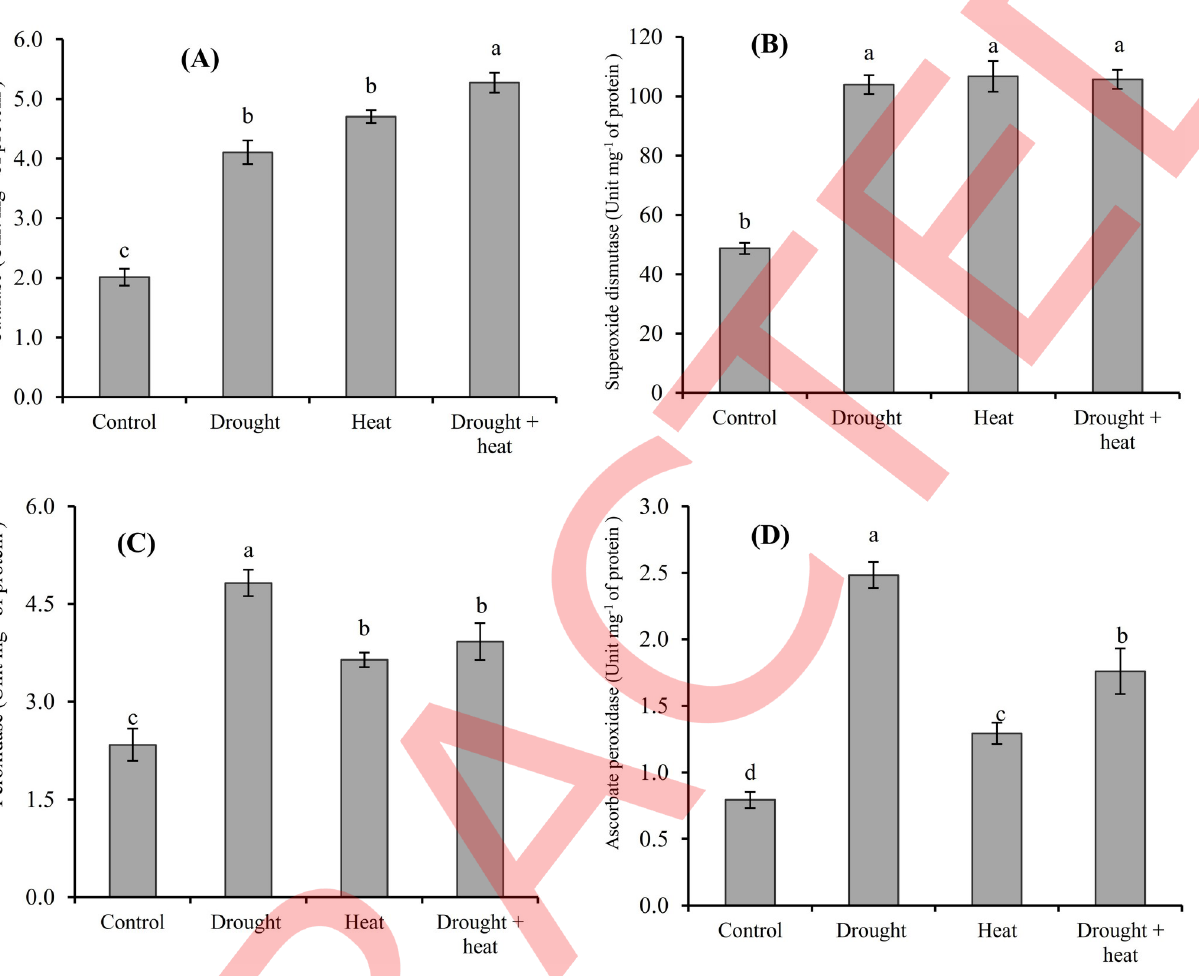
Fig 5. Effects of different drought and heat treatments on Catalase (A), Superoxide dismutase (B), Peroxidase (C) and Ascorbate peroxidase (D) of wheat. Values show mean ± SE (n = 3). Bars sharing the same letters are statistically at par with each other at significance level of 5% ( P � 0.05).